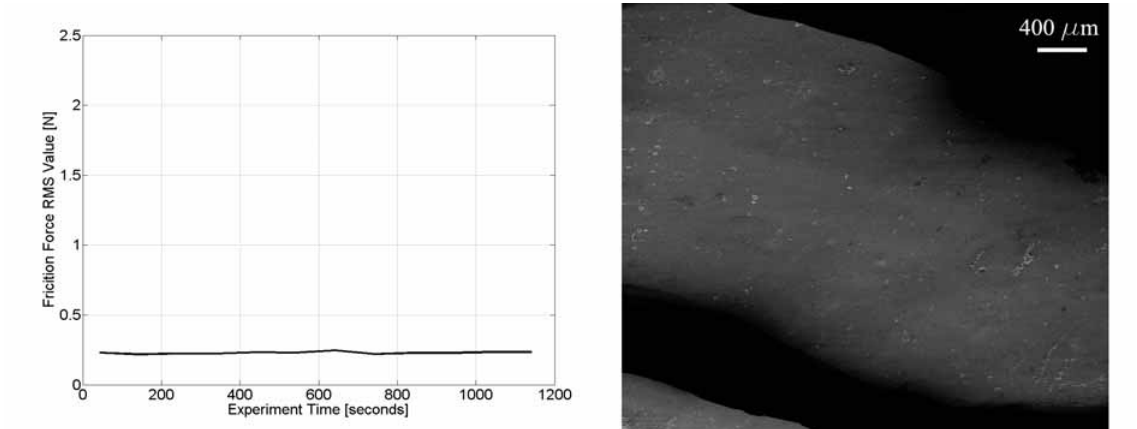
Fig. 15. Estimated friction force and surface SEM photography: Class I experiment.